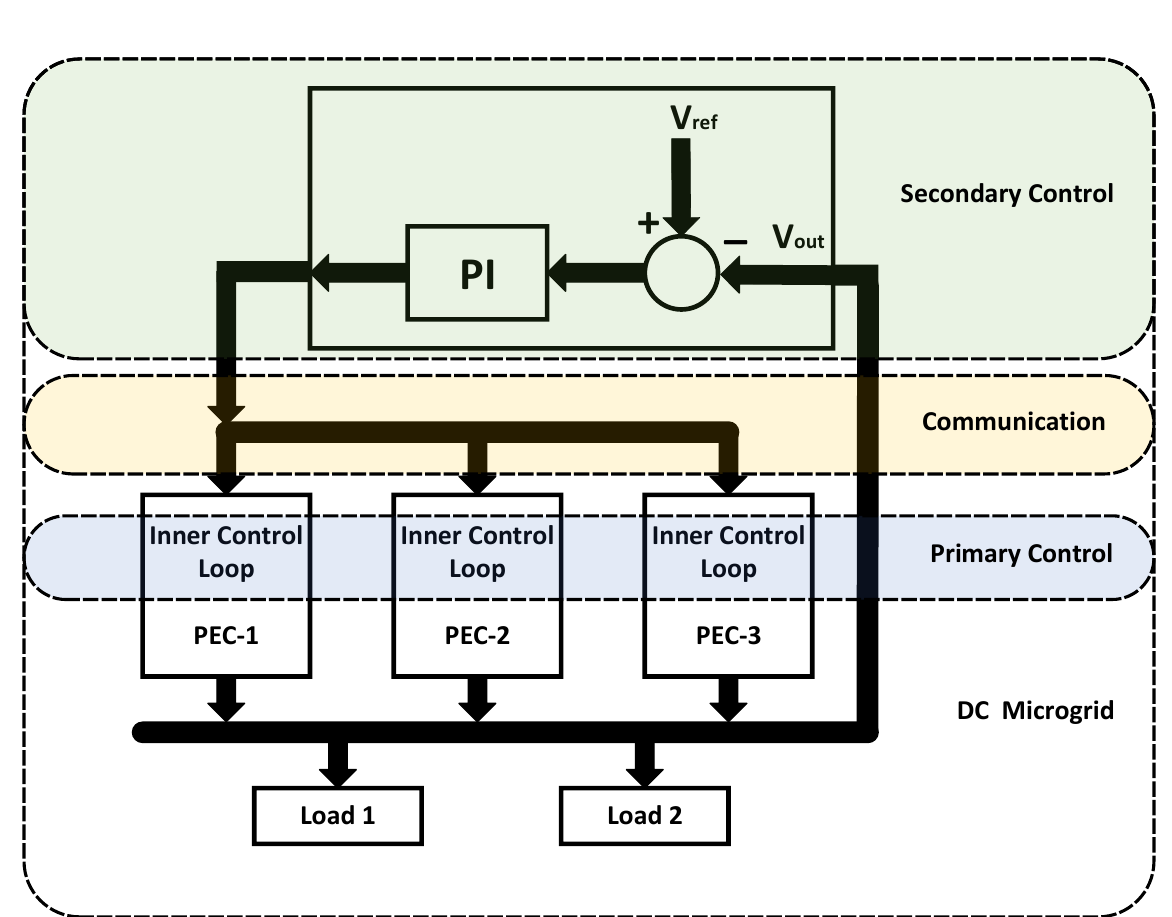
Figure 3. Centralized control scheme for DC